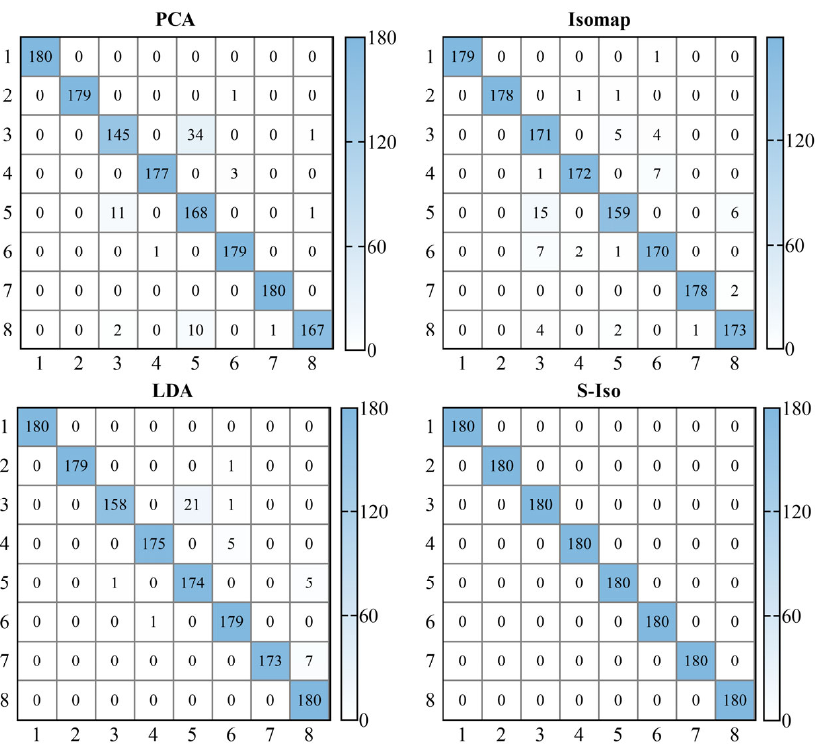
Figure 14. Confusion matrices of four methods.